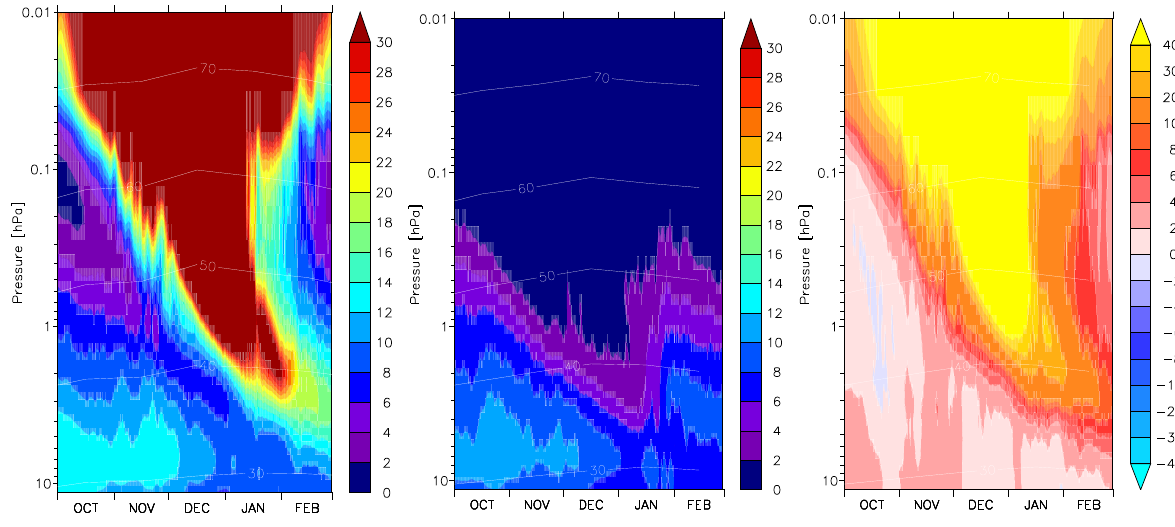
Fig. 6. Left: zonal mean NO x mixing ratios (nmolmol − 1 ) from simulation S-EPP for an exemplary Northern Hemisphere winter poleward of 60 ◦ N. Middle: as left panel, but from simulation S-noEPP. Right: mixing ratio difference NO S − EPP x − NO S − noEPP x . Red-yellow/blue colours indicate positive/negative differences. The white contour lines denote the altitude in km in all panels.